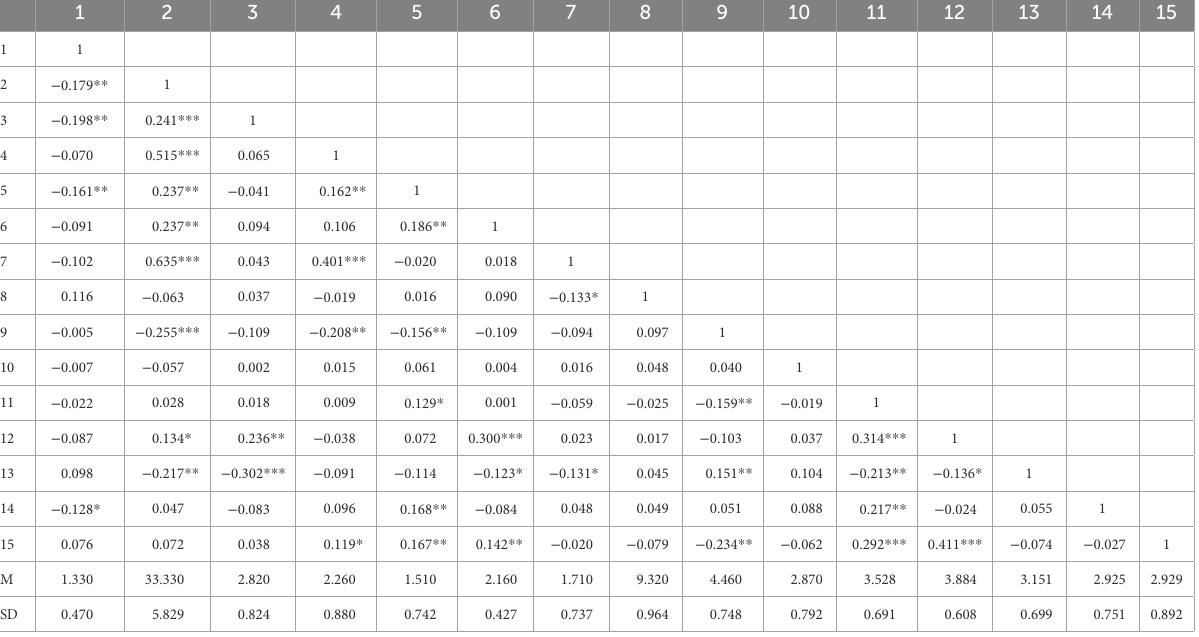
TABLE 3 Correlation and descriptive